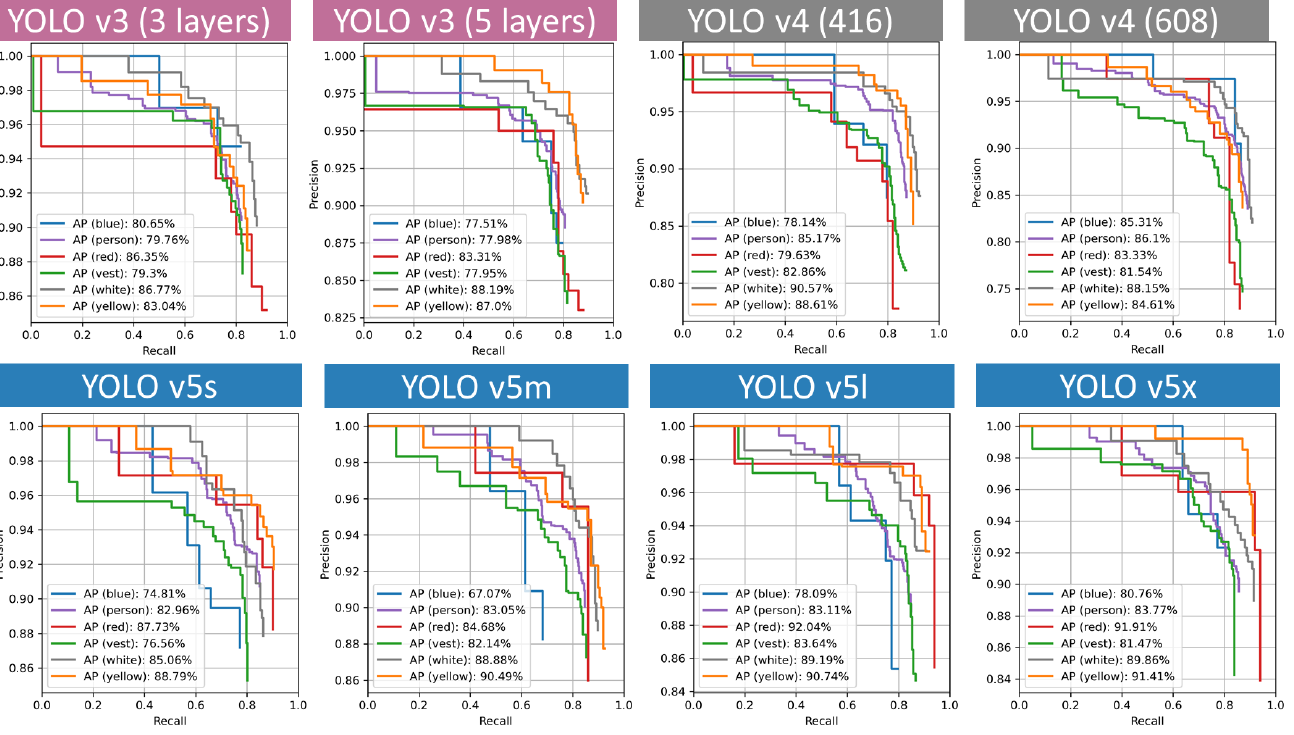
Figure 8. Precision × Recall